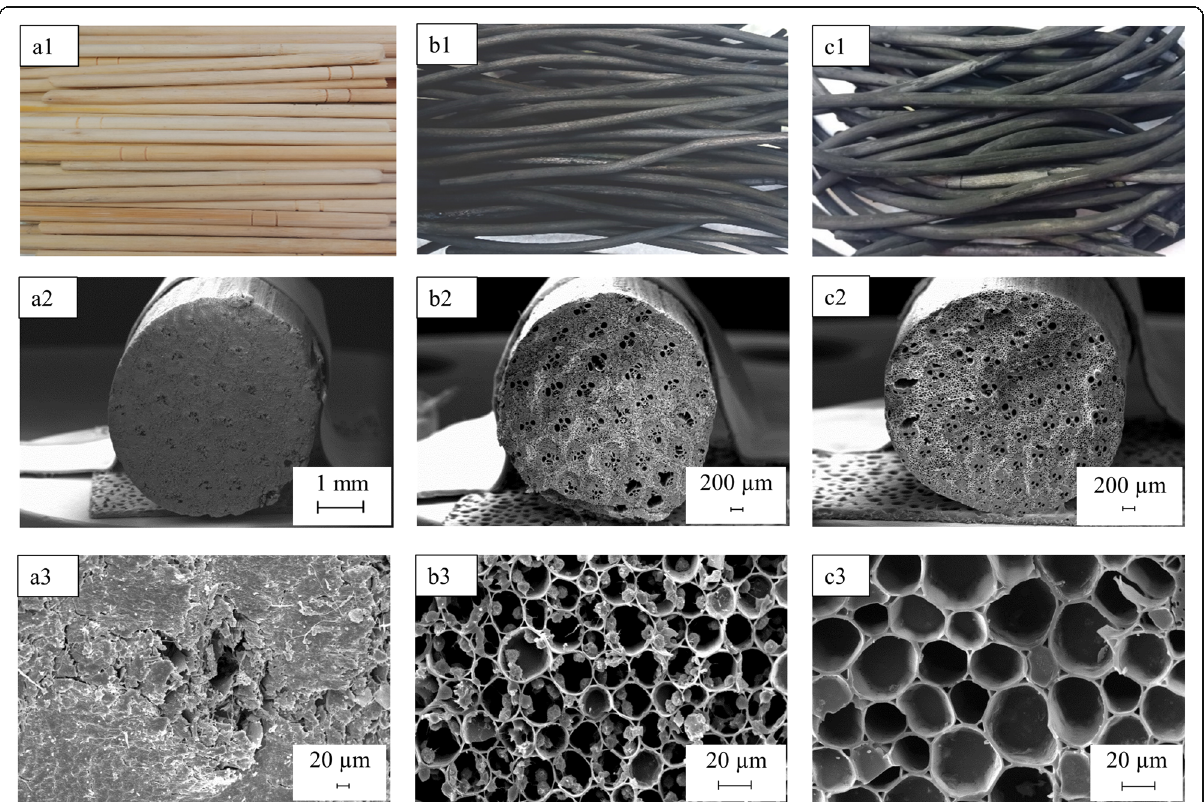
Fig. 2 Photographic images and SEM images of DBC and DBC charcoal: (a1) photograph of DBC; (a2 and a3) SEM of DBC; (b1) photograph of 650 °C DBC charcoal; (b2 and c2) SEM of 650 °C DBC charcoal; (c1) photograph of 900 °C DBC charcoal; (c2 and c3) SEM of 900 °C DBC